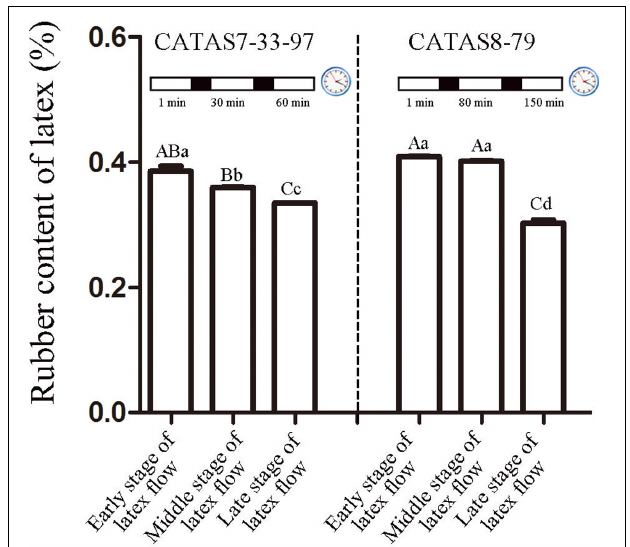
FIGURE 1 | Rubber content of latex across three stages of latex flow between CATAS7-33-97 and CATAS8-79. The capital letter represents p < 0.01 while lower case represents p < 0.05. The same letter indicated no significant difference among